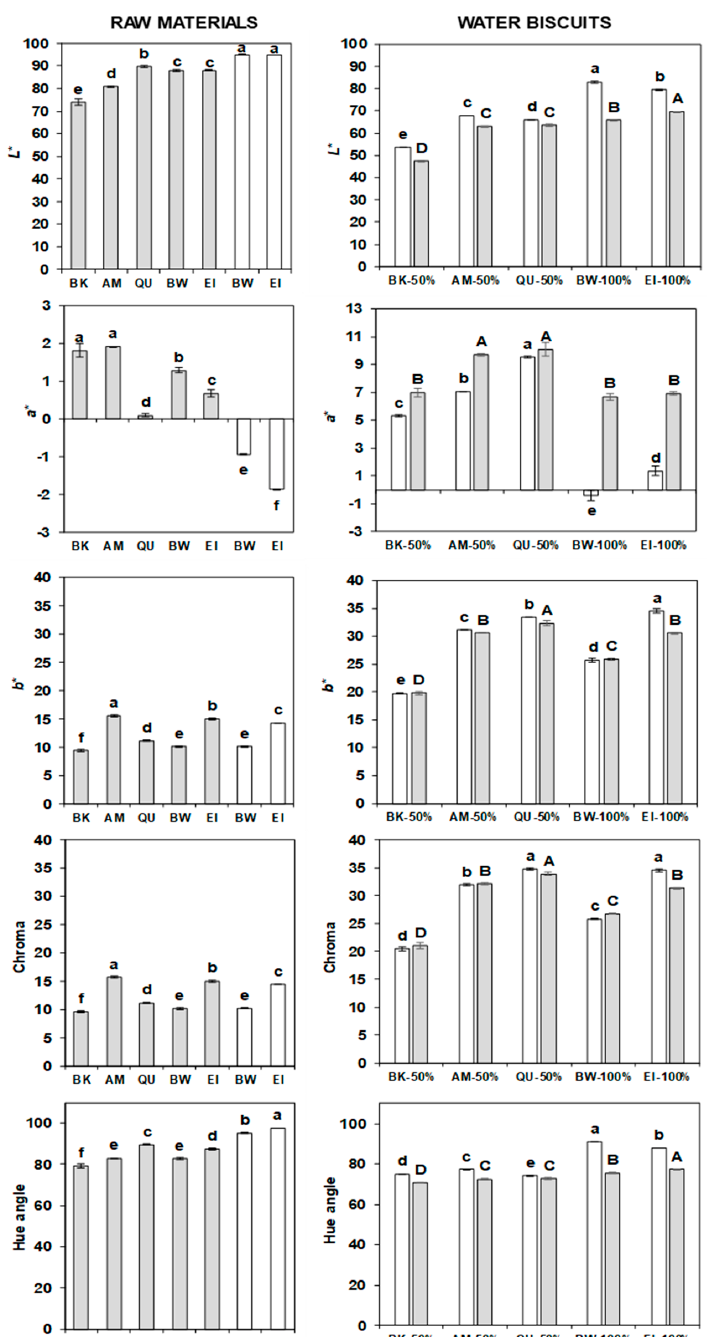
Figure 6. Colour coordinates, chroma and hue angle of the buckwheat, amaranth, quinoa, bread wheat and einkorn wholemeal and of the bread wheat ad einkorn refined flours ( left side) and of the water biscuits prepared with 50% einkorn flour and 50% amaranth, quinoa or buckwheat wholemeal, or 100% einkorn flour or 100% bread wheat flour (empty bars) or prepared with 50% einkorn wholemeal and 50% amaranth, quinoa or buckwheat wholemeal, or 100% einkorn wholemeal or 100% bread wheat wholemeal (grey bars). The error bars represent the standard deviation; different lower case letters indicate significant differences ( p < 0.05) among samples prepared with einkorn refined flour, while capital letters indicate significant differences ( p < 0.05) among samples prepared with einkorn wholemeal ( right side).